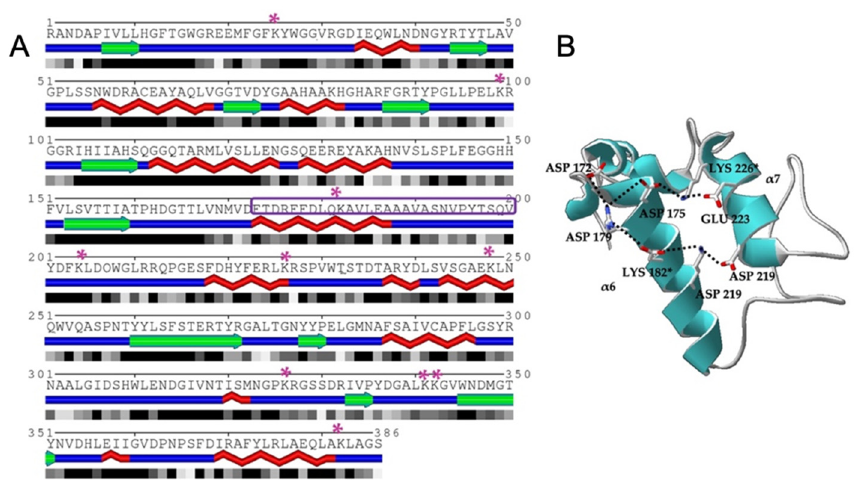
Figure 1. ( A ) Expected secondary structures based on the amino acid sequence of the LipMatCCR11 lipase are depicted; Lys residues are marked with a purple * and lid sequence is delimited by a purple rectangle (model generated in http://sable.cchmc.org/, accessed on 23 October 2021) [35]. ( B ) LipMATCCR11 Lid domain generated with MODELLER v1.11 tool [36]; Lys 182 and Lys 226 participate in the lid opening.